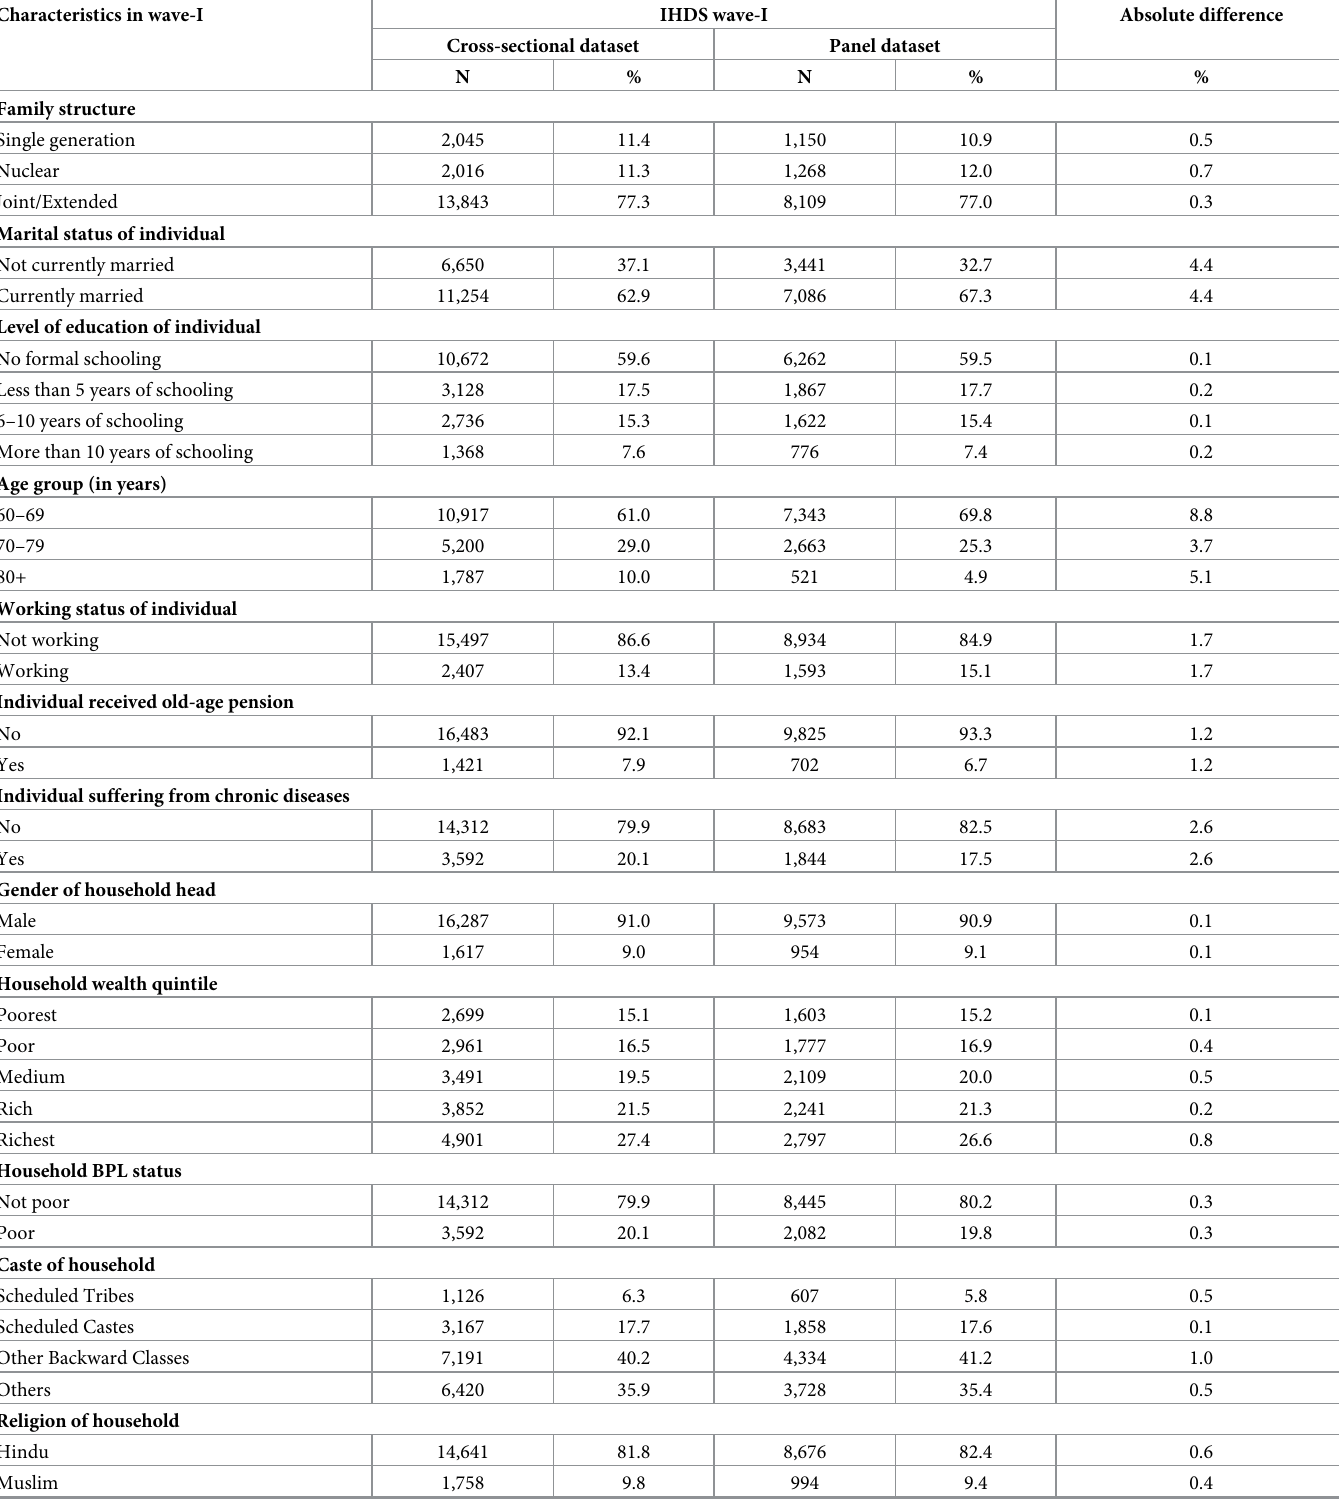
Table 1. Distribution of older adults by socio-economic and demographic characteristics across cross-sectional and panel datasets during wave-I. Characteristics in